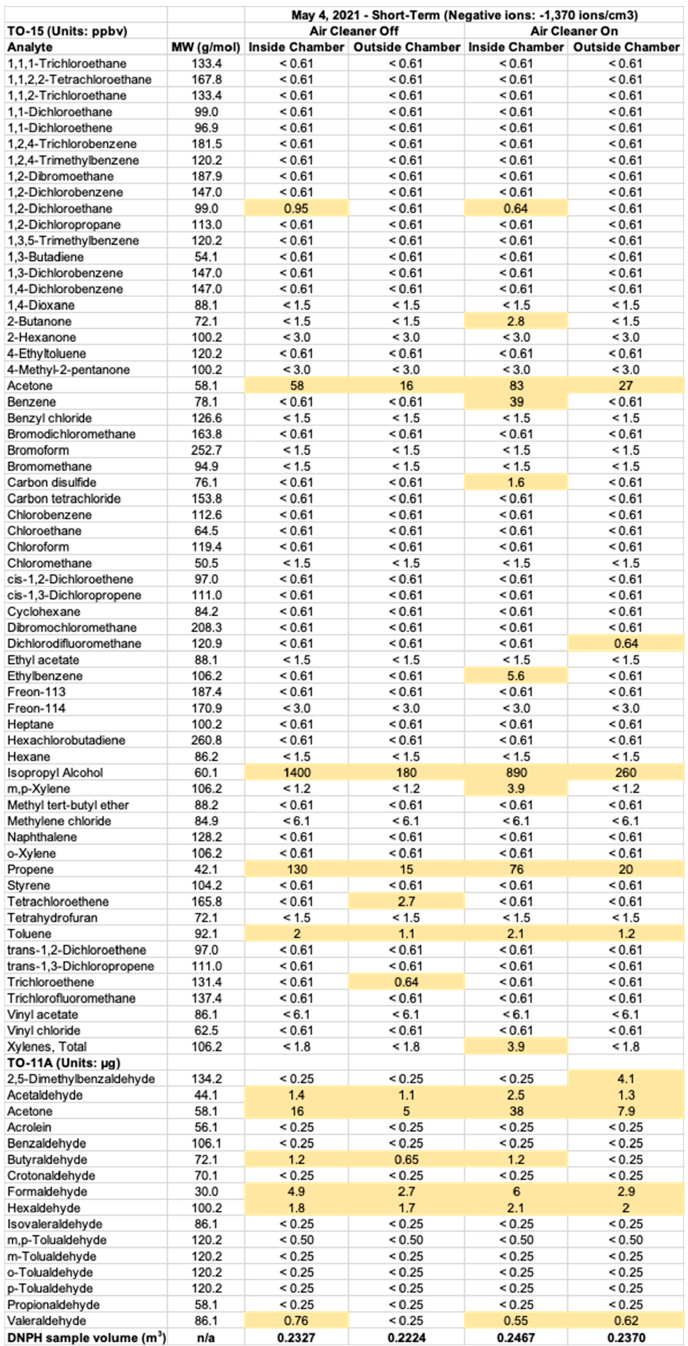
Figure A1. TO-15/TO-11A analytes and reported concentrations: 4 May 2021 short-term test.